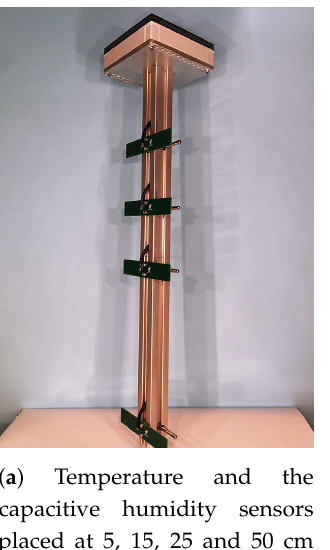
Figure 5. Humidity and Temperature Measurement Wireless